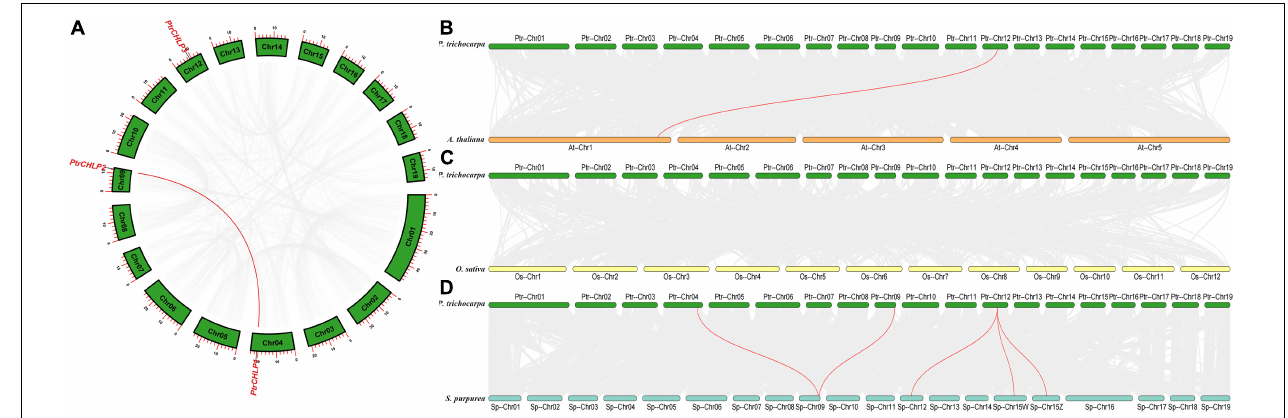
FIGURE 2 | Synteny analysis of poplar CHLP gene family. (A) The synteny analysis of CHLP genes in P. trichocarpa . (B–D) Synteny analysis of CHLP genes between poplar and the other three typical plant species ( A. thaliana, O. sativa, and S. purpurea ). The synteny blocks in poplar and the other species are shown in gray lines, whereas the collinearity of CHLP gene pairs is emphasized in red lines from different